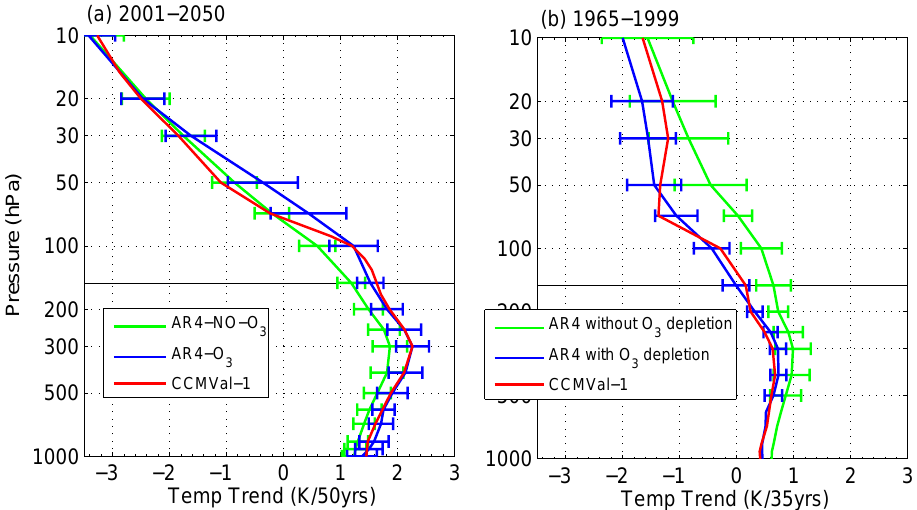
Fig. 2. Vertical profiles of global annual mean temperature trends for each ensemble-mean group for the periods of (a) 2001–2050 and (b) 1965–1999. The error bars indicate one standard deviation only for IPCC models, and error bars for CCMVal-1 models are not plotted. Statistical significance levels of temperature trends at all levels are all higher than the 95% confidence level, and trend differences among the three groups of models are also statistically